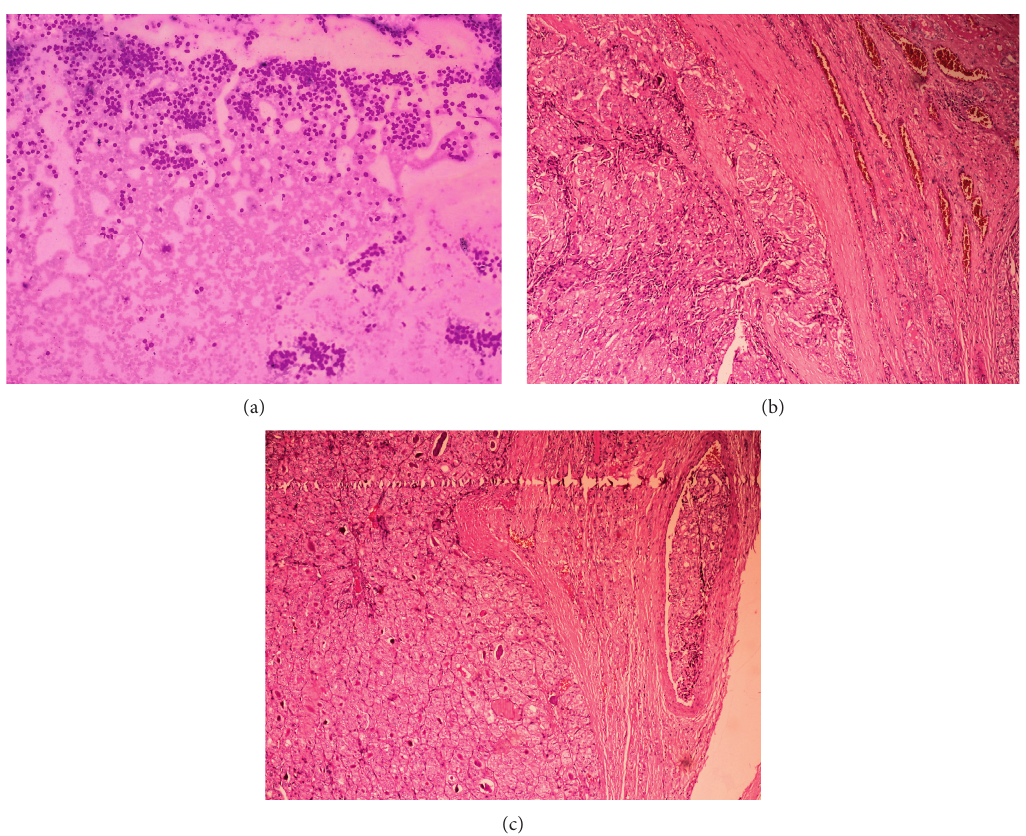
Figure 2: Follicular neoplasm/suspicious for follicular neoplasm (Bethesda category IV). (a) Highly cellular smear with cells arranged predominantly in microfollicular pattern (MGG × 100). Histopathology of the same showed follicular carcinoma with capsular invasion (b) and vascular invasion (c) (H&E ×